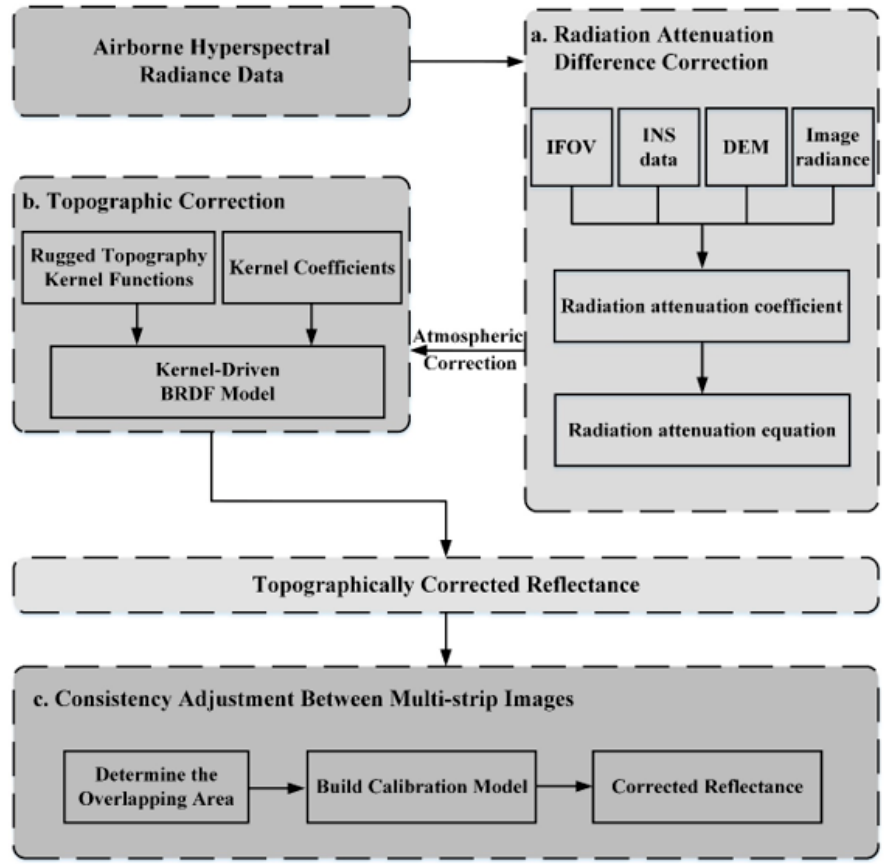
Figure 2. Processing flowchart of airborne hyperspectral images radiation distortion correction.